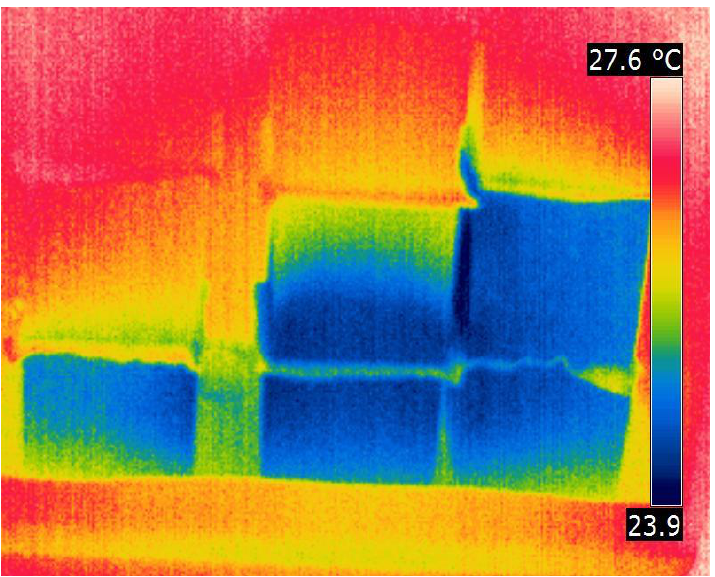
Figure A4. Thermographic report dated October 12, 2018, for Carparo (C.), Lecce stone (L.S.), and Tuff (T.).